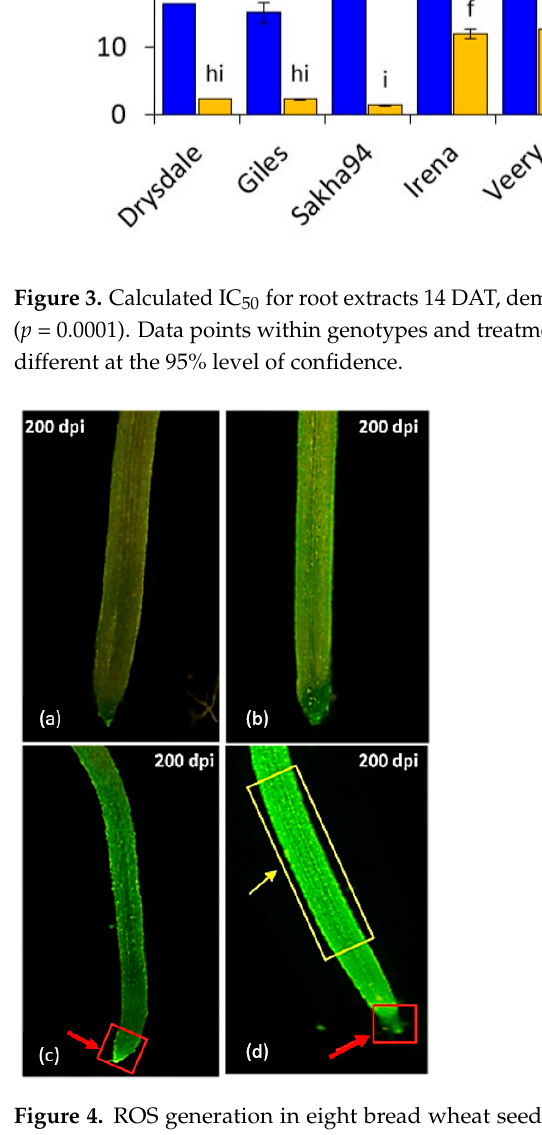
Figure 4. ROS generation in eight bread wheat seedling roots at 14 DAT. ( a ) Control for adapted genotypes; ( b ) control for non-adapted genotypes; ( c ) osmotic treatment for adapted genotypes; ( d ) osmotic treatment for non-adapted genotypes. In sensitive genotypes’ root tip, the areas of